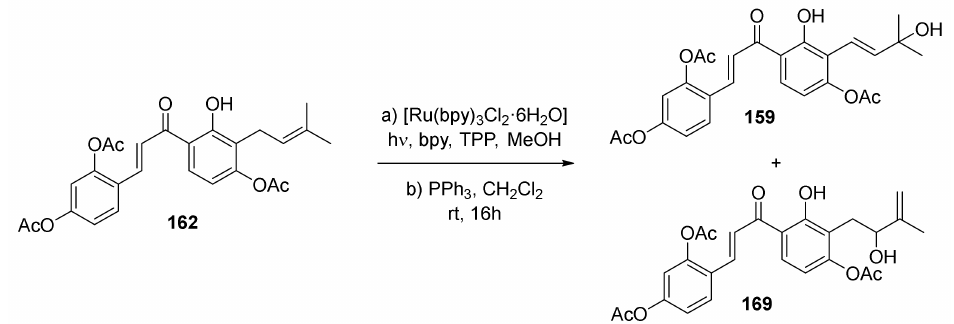
Figure 56. Schenck ene reaction towards tertiary alcohol 159 .